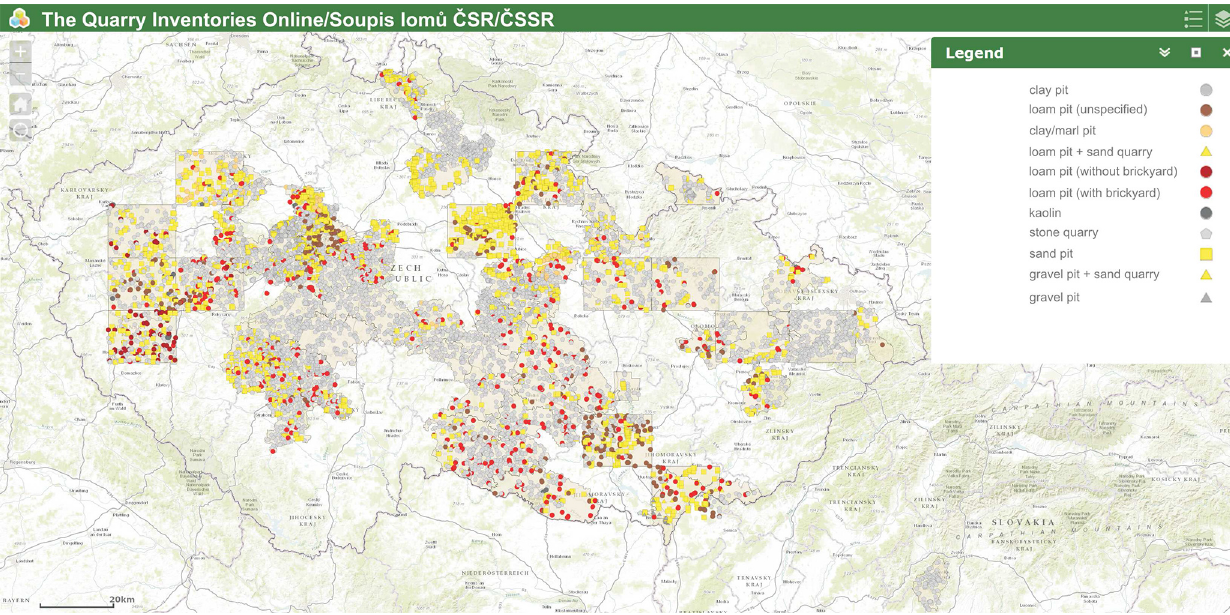
Figure 4. Screenshot of “the Quarry Inventories Online” web map